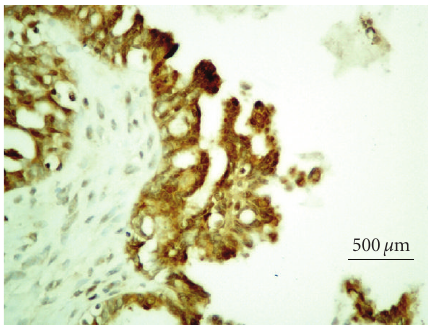
Figure 2: Immunohistochemistry positive staining of anti- iNOS polyclonal antibody (serous cystadenocarcinoma, 400x, diaminobenzidine).